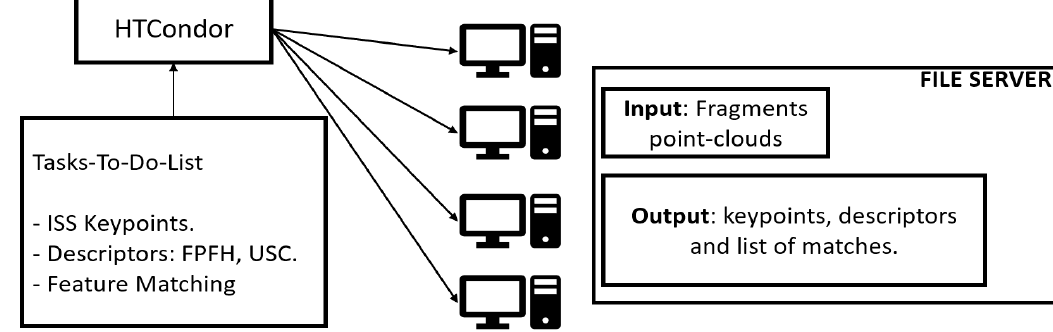
Figure 8. Jobs distribution in HTCondor to perform brute force